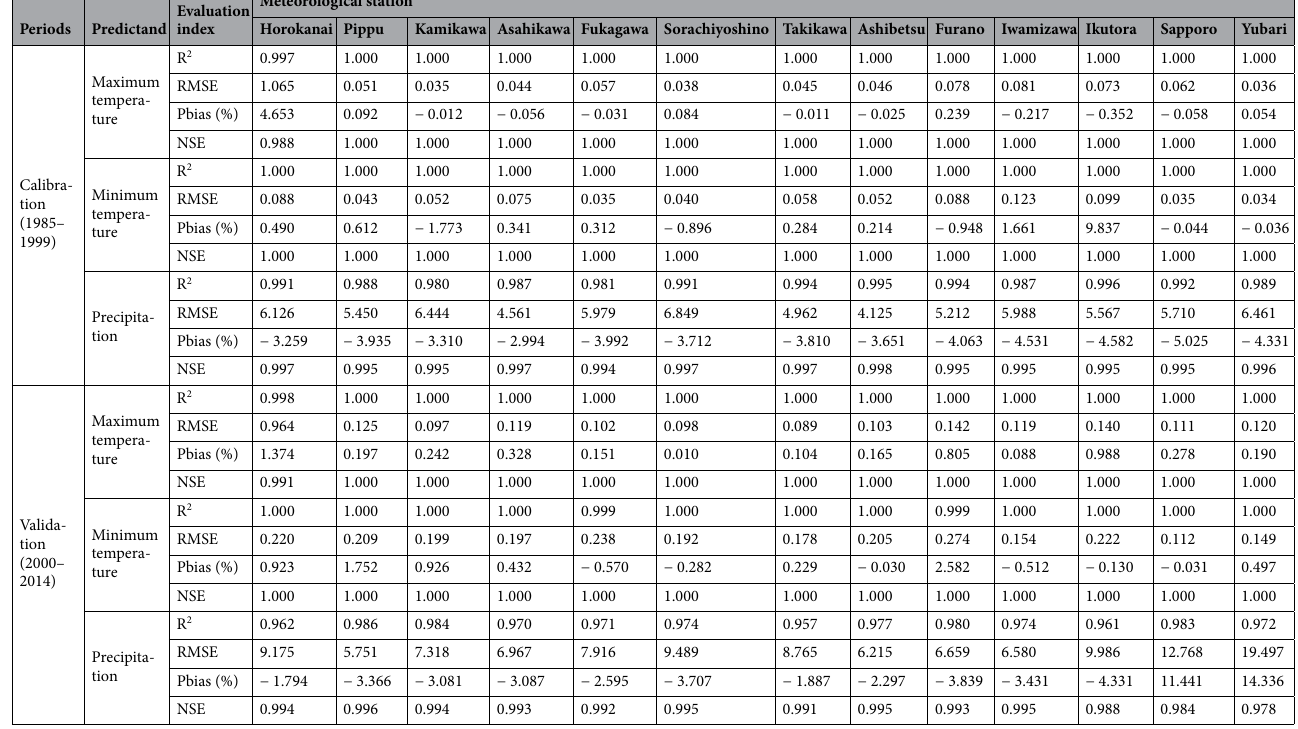
Table 3. SDSM-based evaluation metrics of each station during the phases of calibration (1985–1999) and validation